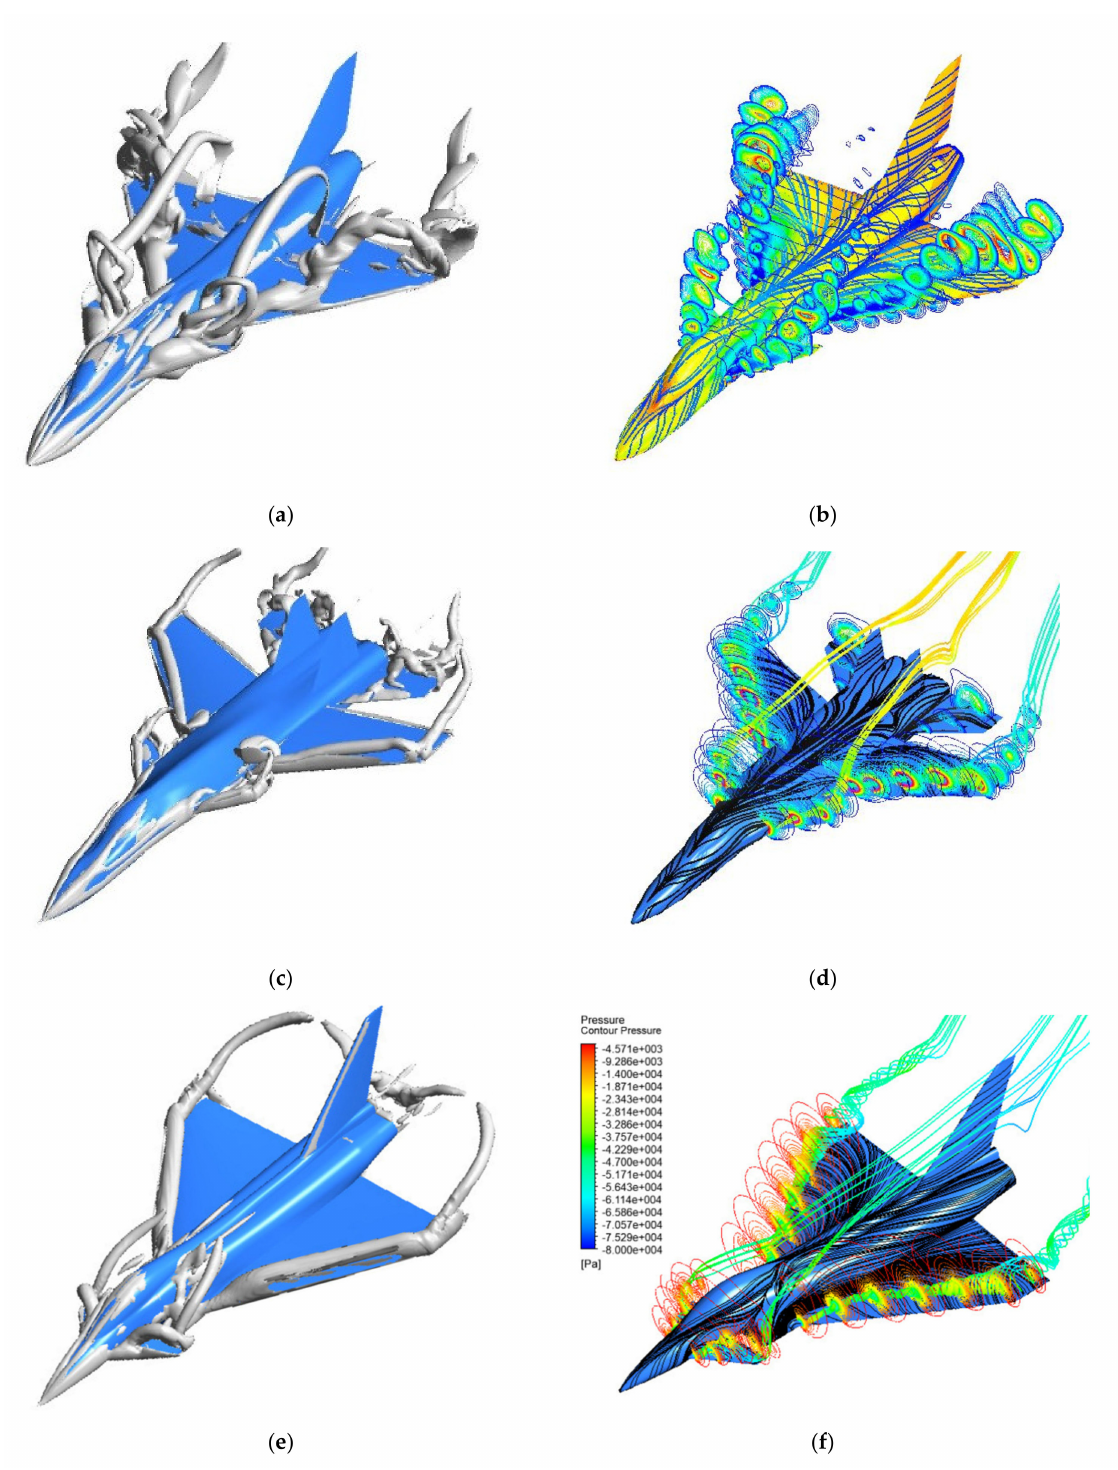
Figure 9. Computational fluid dynamics (CFD) visualization of vortex core (VC), pressure contour, wall shear streamline and velocity streamlines at AoA 40 ◦ ; ( a ) VC, J10; ( b ) J10 streamlines; ( c ) VC, SU-30; ( d ) SU-30 streamlines; ( e ) VC, EF-T; ( f ) EF-T